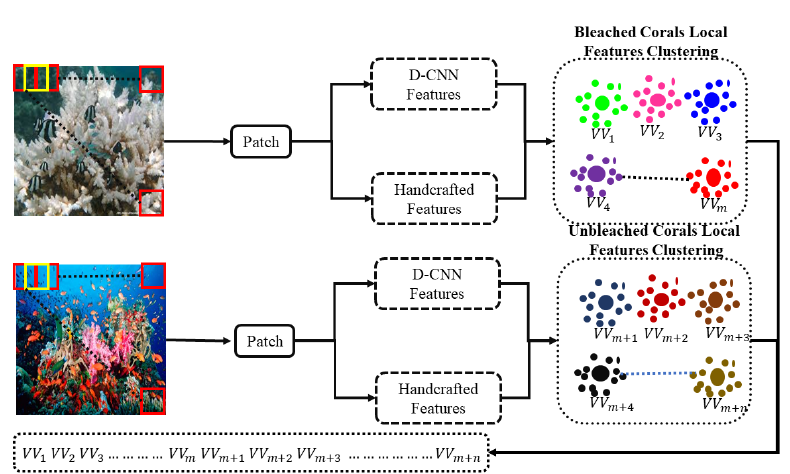
Figure 4. Visual Vocabulary of